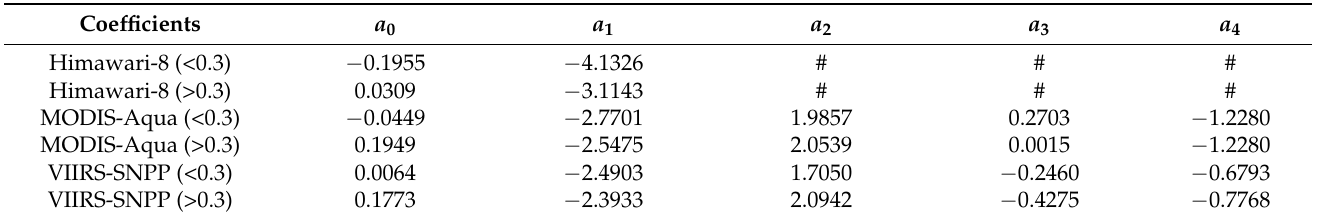
Table 5. Systematic deviation metrics of satellite data before and after algorithm improvement, based